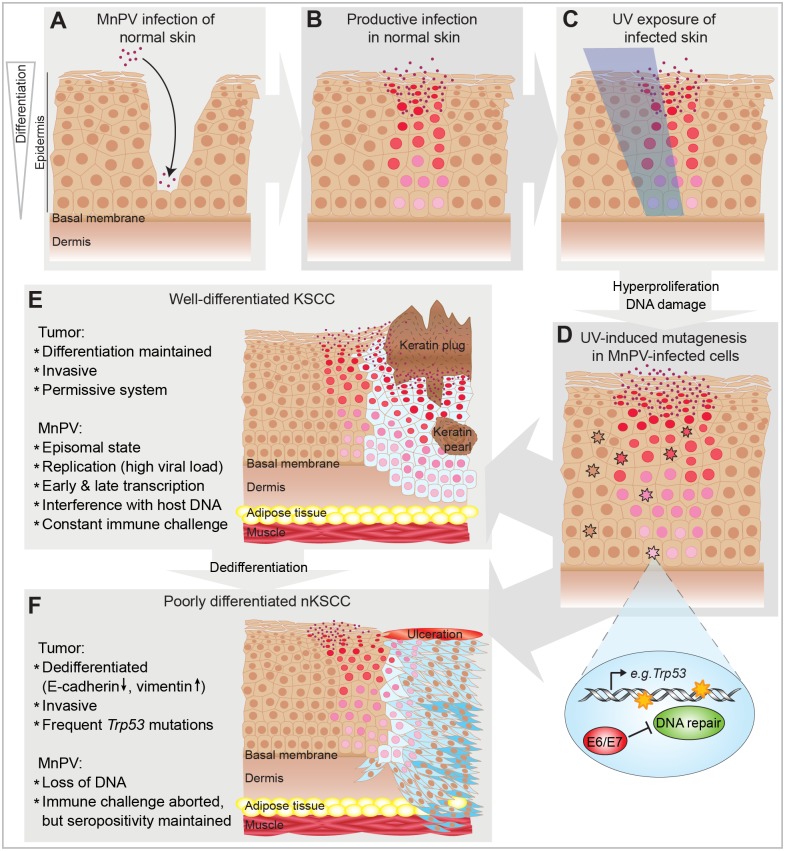
Schematic overview of the mechanism suggested for UV-induced NMSC development in Mastomys coucha.A) MnPV infects basal epithelial cells of the skin of young animals via small injuries. B) MnPV genome is amplified in stratified skin layers (pink and red nuclei) and new virions are released. C) UVB irradiation of the skin. D) UVB-irradiated skin is hyperproliferative, favoring viral replication and virion formation. UVB-induced photoproducts, e.g. in Trp53, occur in keratinocytes (altered nuclei). In uninfected cells, damages are repaired. In infected cells, MnPV-E6/E7 reduce chromosomal stability and inhibit DNA repair. Mutations can accumulate and altered cells become neoplastic. E) Neoplastic squamous cells (light blue) start forming a well-differentiated keratinizing SCC, still representing a permissive system that allows viral replication and formation of virions. F) When neoplastic squamous cells accumulate further mutations (dark blue), a spindle cell phenotype is acquired, forming a poorly differentiated SCC that may become ulcerated. MnPV cannot replicate in dedifferentiated cells and the viral DNA is subsequently lost.